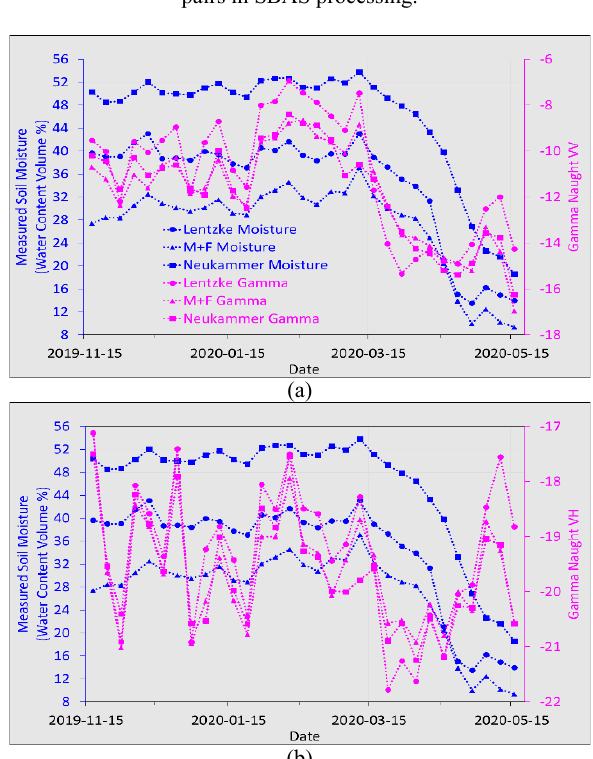
Figure 6. Comparison of soil moisture and Gamma Naught of (Figure